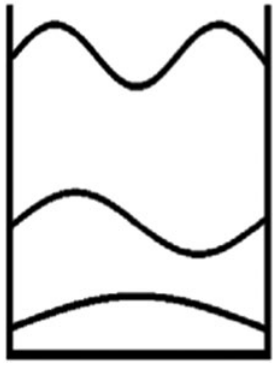
FIG. 1. A typical diagram as found in many textbooks, which simultaneously shows wave functions and energy